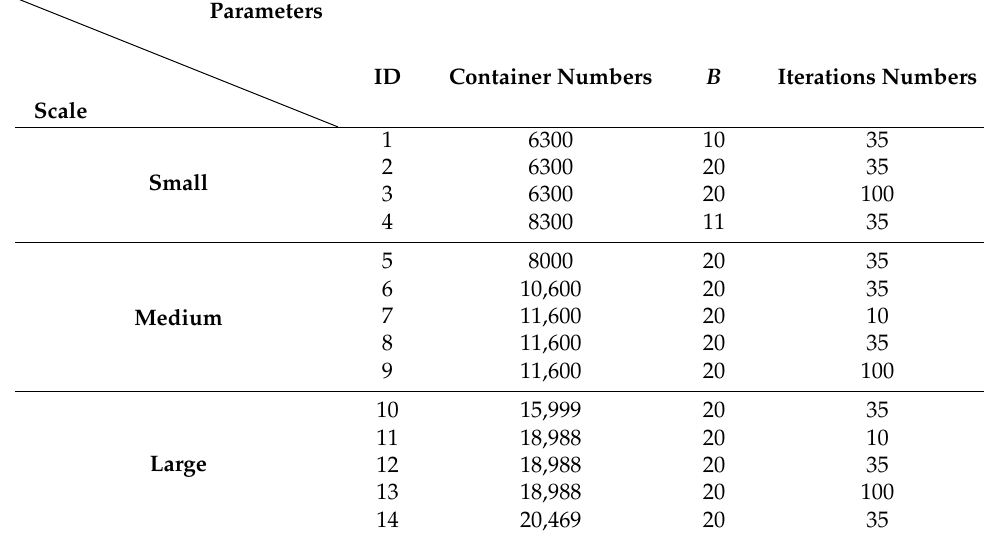
Table A3. Extra parameter settings. “ID” represents the serial number of the numerical experi- ments. “Container Numbers” represents the number of containers leaving from Shanghai Port. “ B “ and “Iterations Numbers” represent the number of feeders and the number of iterations in algorithms,